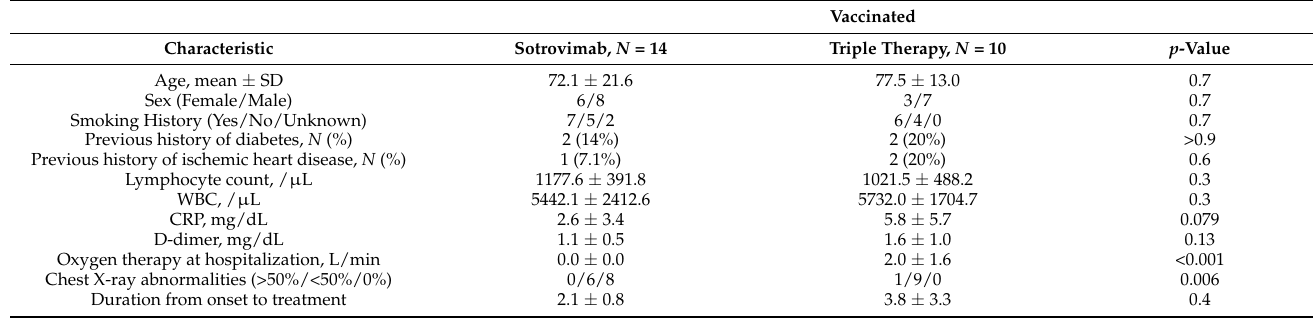
Table 2. Patient characteristics during the BA.1 wave.